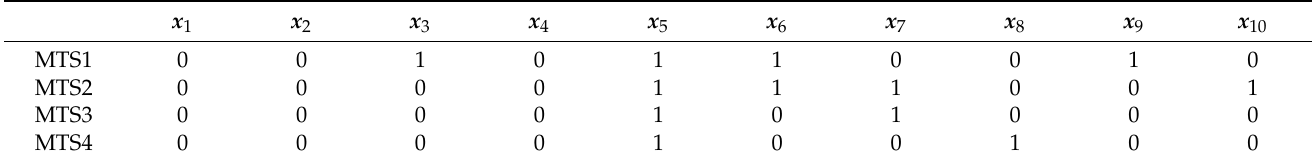
Table 15. Feature variable selection results of Optimized BT-MTS of the Page-blocks data